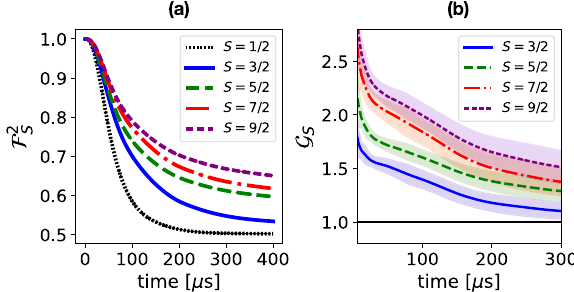
Fig. 7 Performance of spin-binomial codes. a Average squared fi delity as a function of time for different values of the qudit spin S , for ffiffiffi p 2 initial state ψ L j i ¼ ð 0 L j i þ i 1 L j iÞ = and spin-binomial codewords 0 L j i and 1 L j i . The results are averaged over 2 6 nuclear spin con fi gurations. b Gain, de fi ned in Eq. (9), with respect to a spin 1/2, for the same data of panel ( a ). The shaded area are constructed as in Fig.